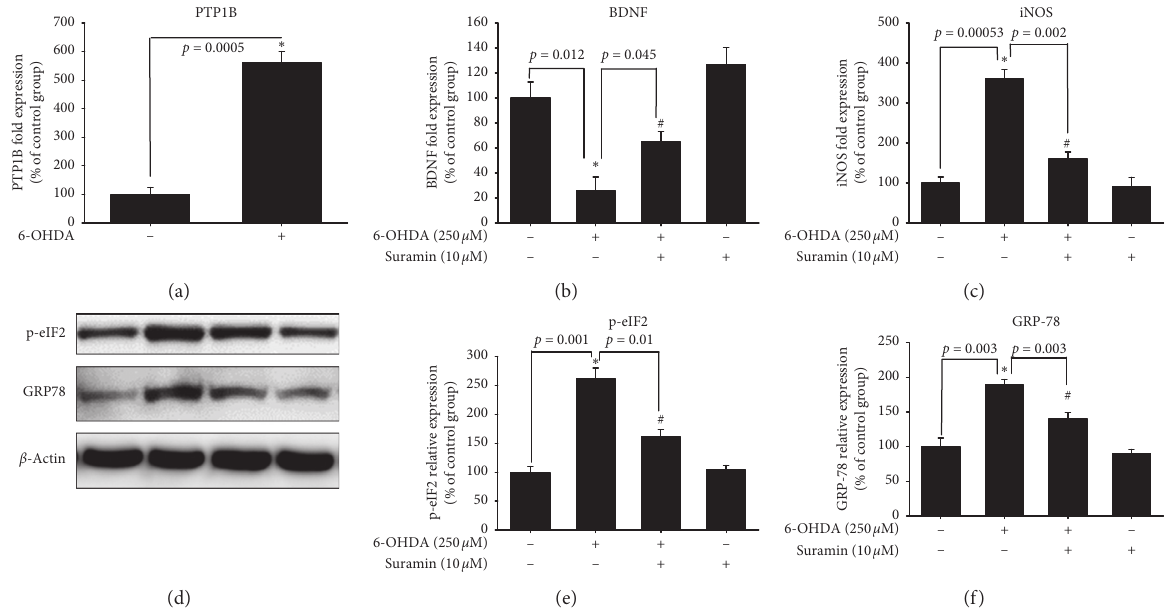
Figure 6: Neuroprotective effect of suramin on the 6-OHDA-induced zebrafish PD model. (a) Zebrafish were pretreated with 10 μ M suramin from 9h after fertilization (hpf) to 3 days after fertilization (dpf) and then challenged with 250 µ M 6-OHDA from 2 to 3 dpf. Quantitative PCR of PTP1B for the control and 6-OHDA groups was performed. (b) Zebrafish were pretreated with 10 μ M suramin from 9 hpf to 3 dpf and then challenged with 250 µ M 6-OHDA from 2 to 3 dpf. Quantitative PCR of BDNF for the control, 6-OHDA, 6-OHDA plus suramin, and suramin alone groups was performed. (c) Zebrafish were pretreated with 10 μ M suramin from 9 hpf to 3 dpf and then challenged with 250 µ M 6-OHDA from 2 to 3 dpf. Quantitative PCR of iNOS for the control, 6-OHDA, 6-OHDA plus suramin, and suramin alone groups was performed. (d) Zebrafish were pretreated with 10 μ M suramin from 9 hpf to 5 dpf and then challenged with 250 µ M 6-OHDA from 2 to 5 dpf. Western blotting of p-eIF2 and GRP-78 for the control, 6-OHDA, 6-OHDA plus suramin, and suramin alone groups was performed. (e) Quantitative results of p-eIF2 protein expression. (f) Quantitative result of GRP-78 protein expression. Data are presented as mean ± SEM, and each value contains three replicates and three samples. ∗ Significantly different from the control; # significantly different from the 6-OHDA